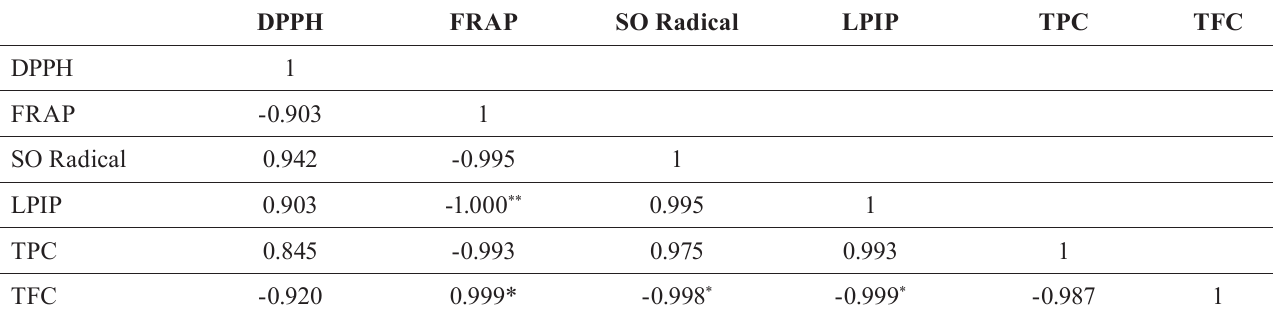
TABLE III - Correlation matrix between antioxidant potential, total phenol and flavonoid